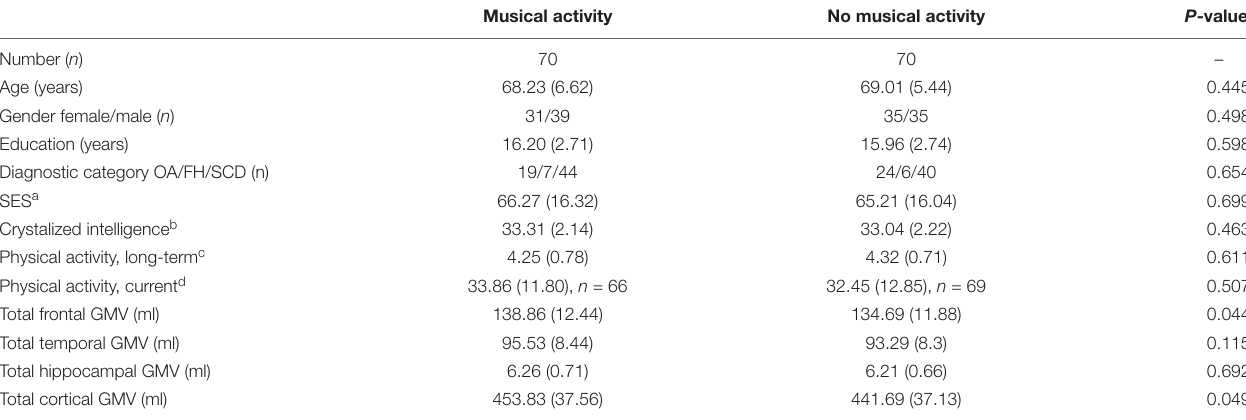
TABLE 1 | Descriptive characteristics of the matched DELCODE sample ( n = 140).